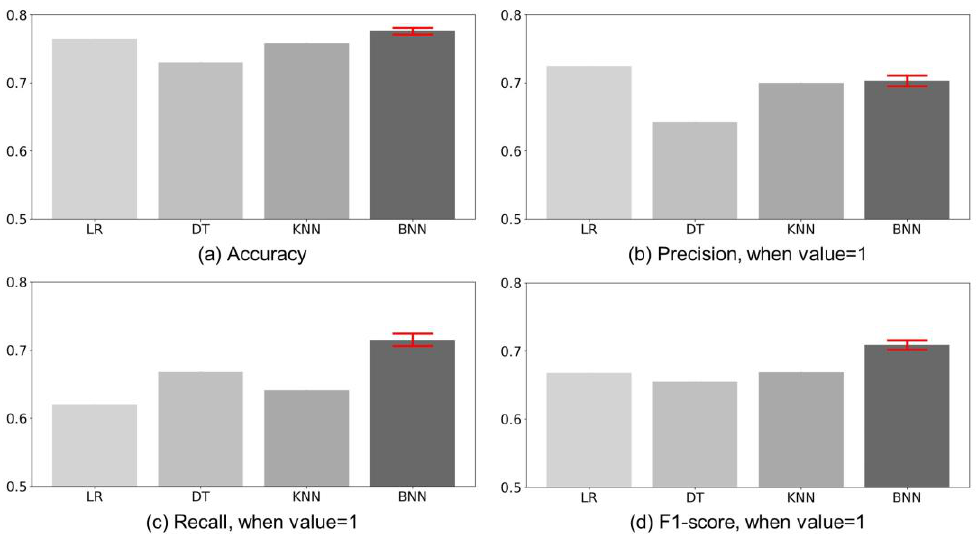
Figure 3. Comparison of predictive performance by model. ( a ) Measuring the accuracy of the mod- els; ( b ) Precision when technology value is high (value = 1); ( c ) Recall when technology value is high (value = 1); ( d ) F1-score when technology value is high (value = 1).